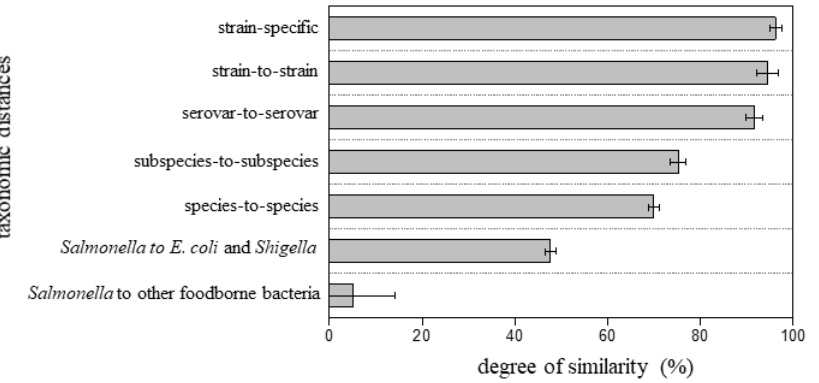
Figure 5. Degree of similarity of the fifteen Salmonella isolates to reference proteomes with various taxonomic distances.